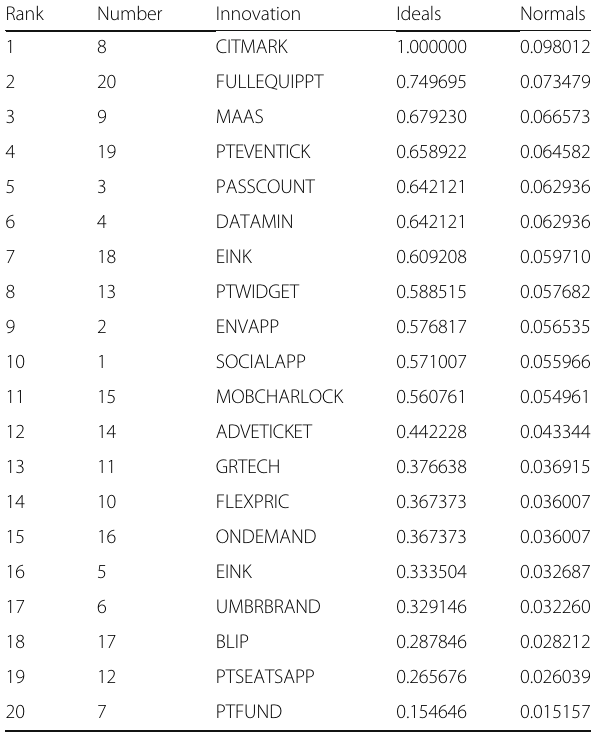
Table 5 Ranking of innovations with respect to Feasibility